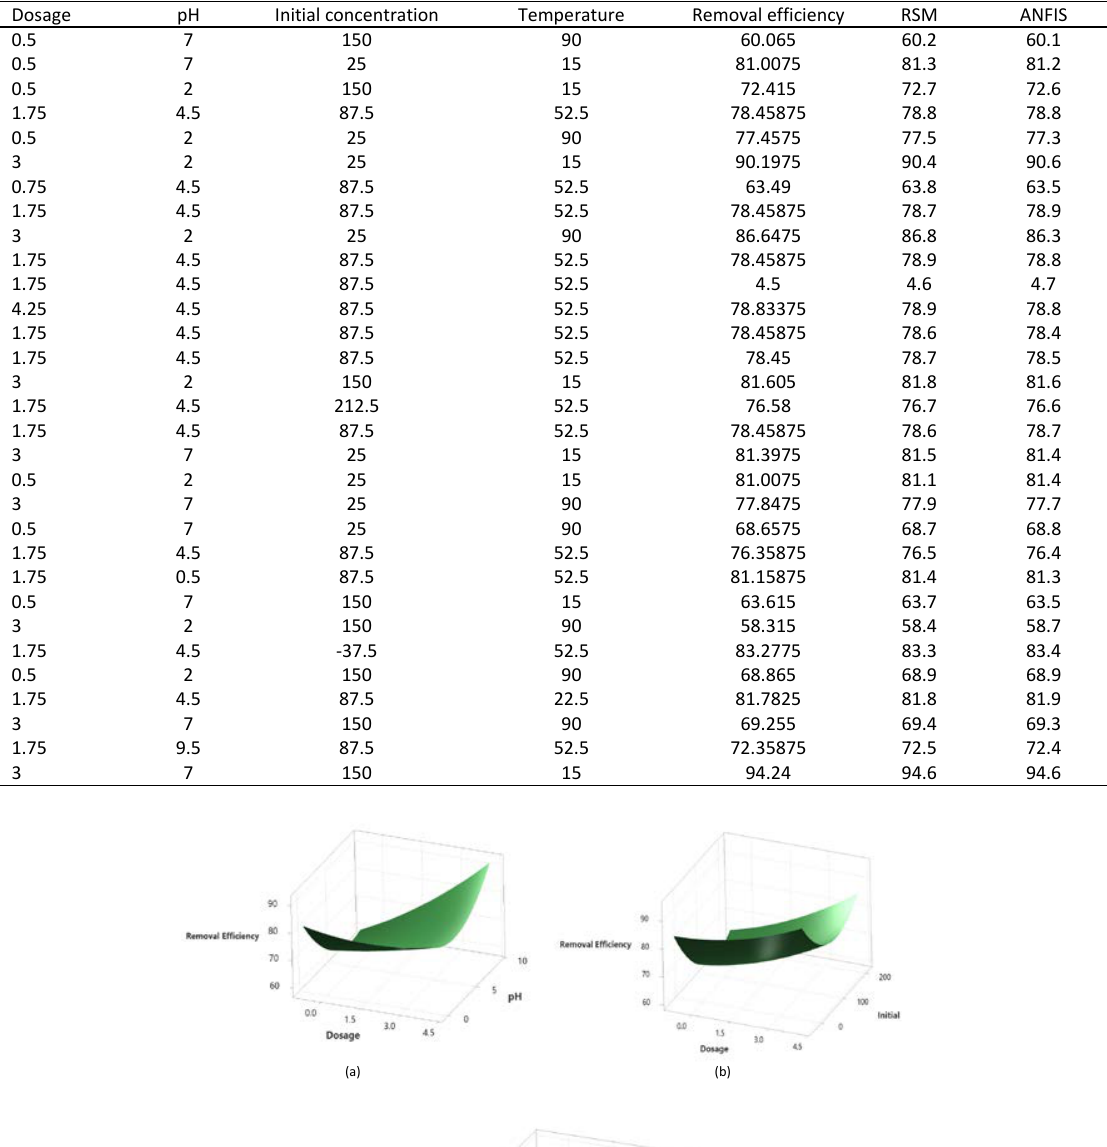
Table 3: Removal efficiency of experimental, RSM and ANFIS models for batch study